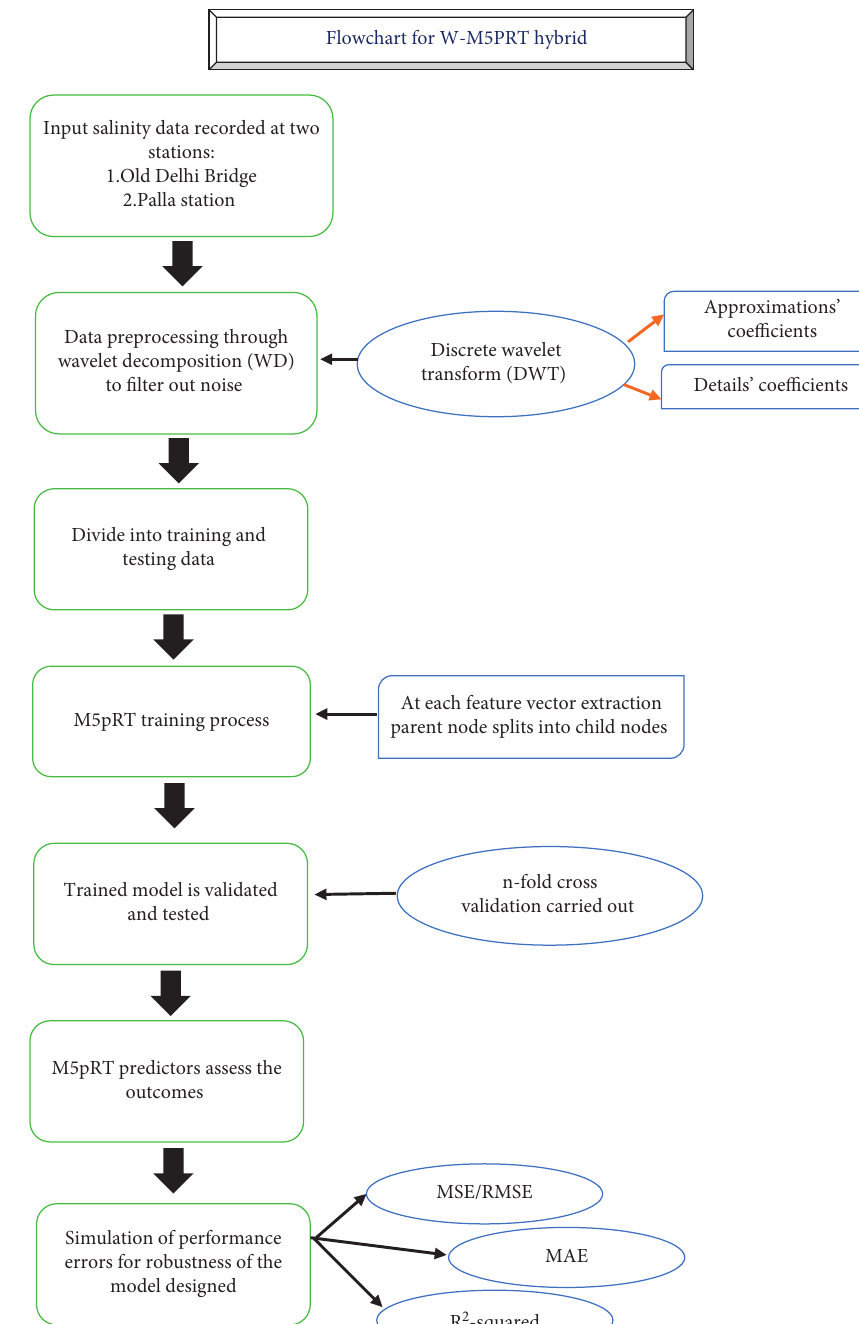
Figure 4: Flowchart of wavelet M5pRT